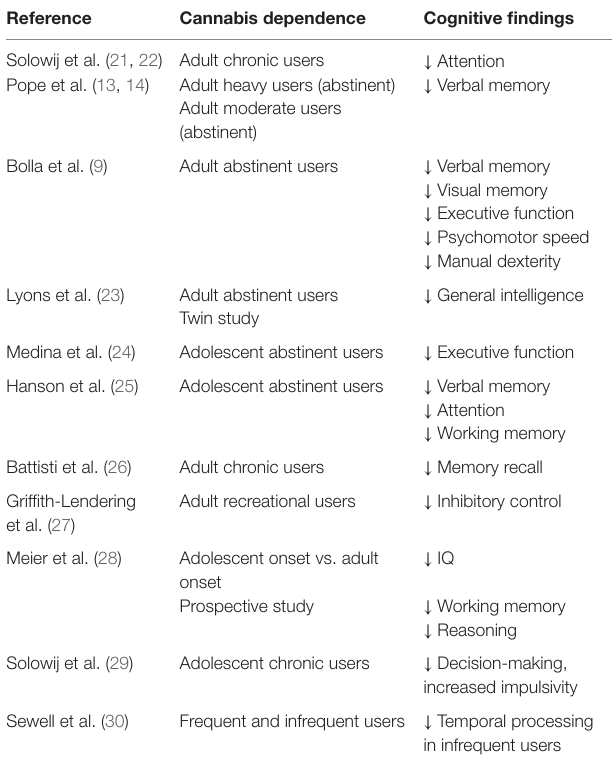
TABLe 1 | Cognitive deficits reported in marijuana